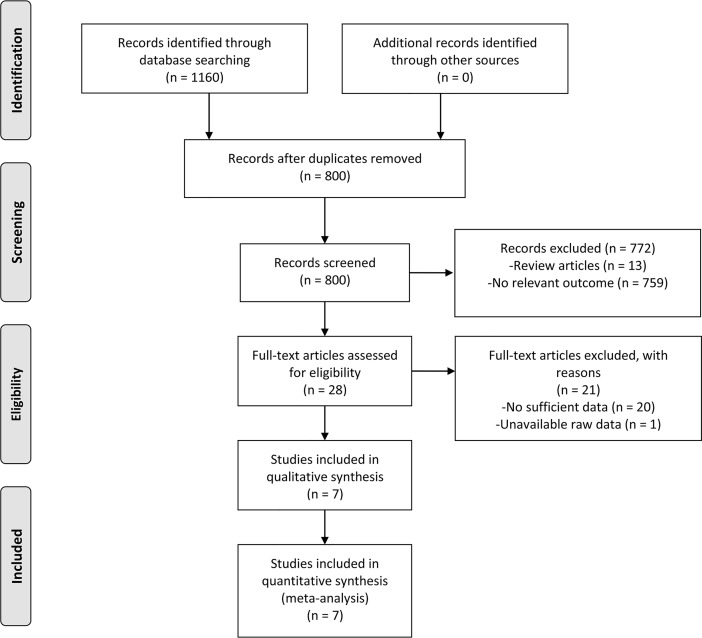
Flow illustration for studies selection process.